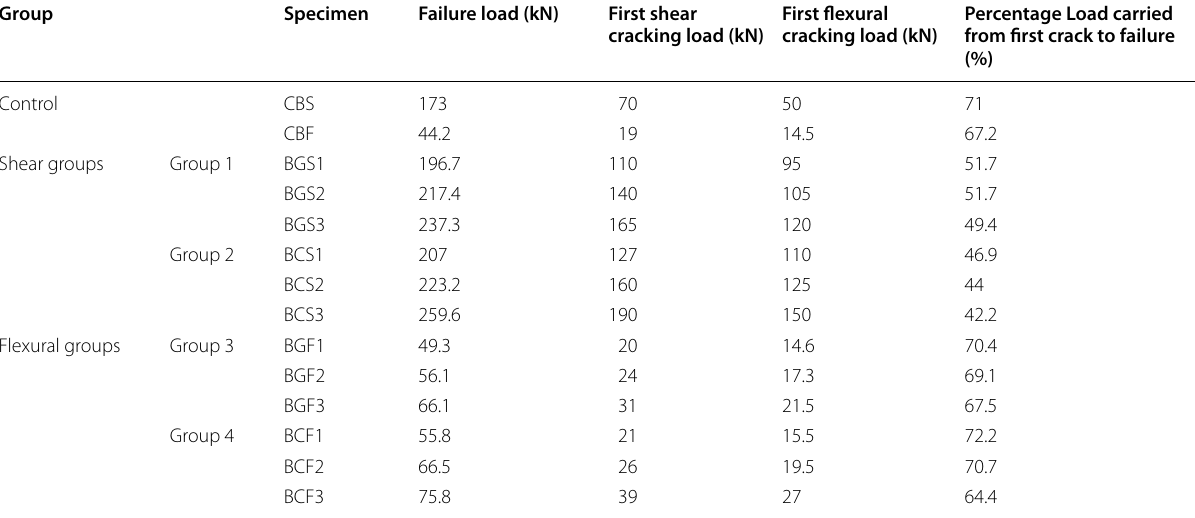
Table 4 Load at first shear crack, first flexural crack and at failure.